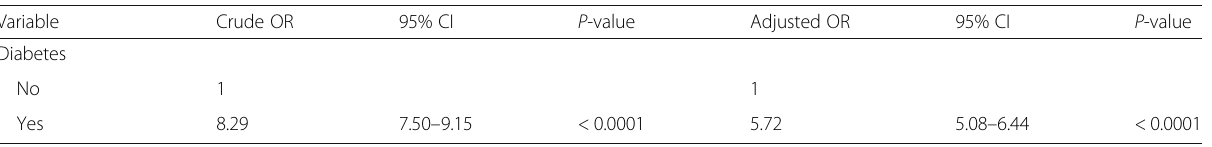
Table 2 Univariate and multiple logistic regression analyses for the relationship between potential factors and type 2 diabetes screening (Continued)